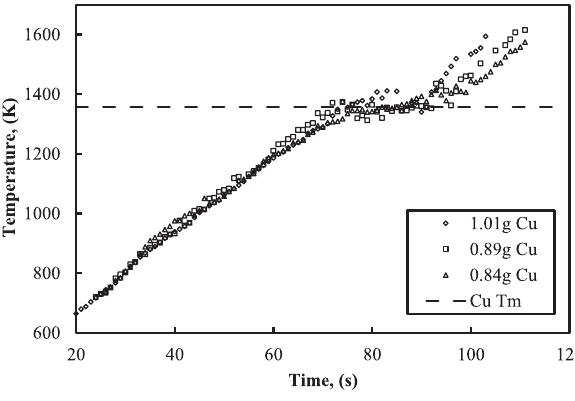
Fig. 5: Pyrometer calibration using copper droplets of different